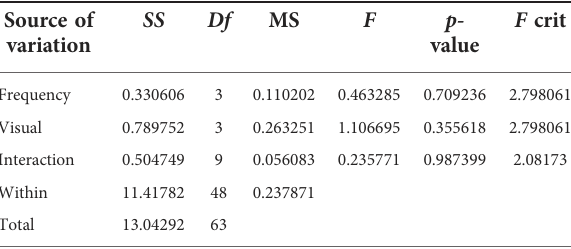
TABLE 2 Signi fi cance of frequencies and visual conditions and the interaction between them. ANOVA Source